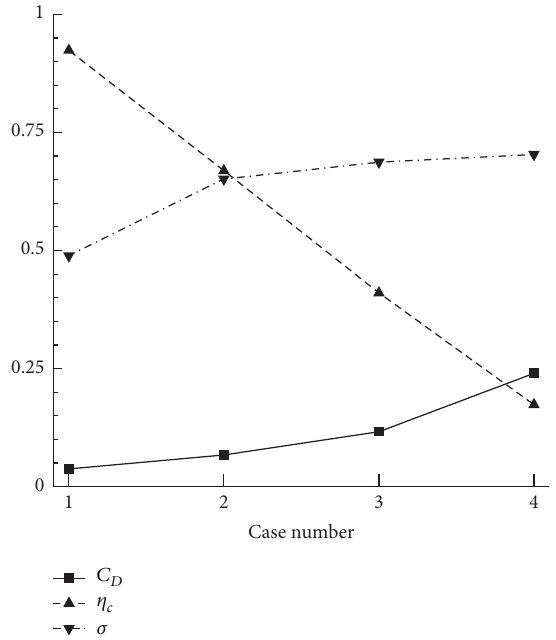
Figure 8: Effects of the fuel injection location on the overall